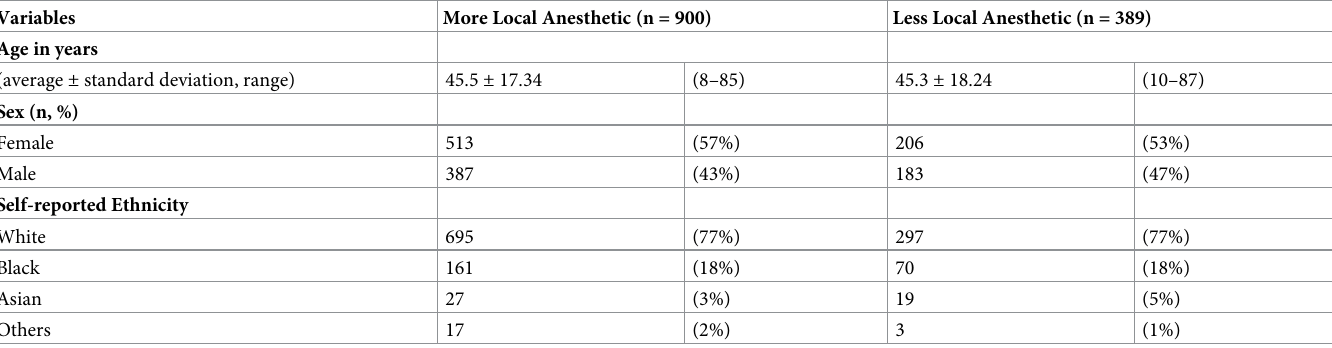
Table 1. Description of the study sample.